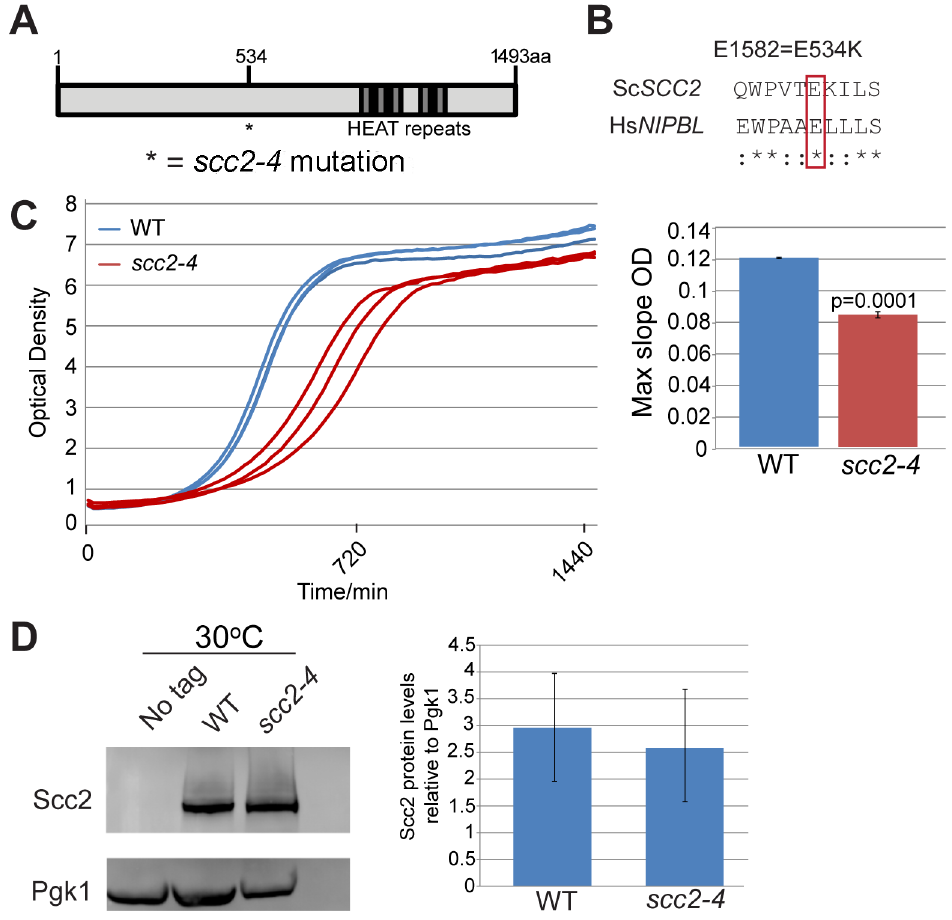
Fig 1. scc2-4 is a partial loss of function mutation. (A) Scc2 has conserved HEAT repeats in the C terminal domain. (B) The amino acid mutated in scc2-4 is conserved from yeast to human (E534). (C) A growth curve of the WT and scc2-4 mutant strains in YPD at 30°C is shown (left). Growth curves were measured using a TECAN machine. The scc2-4 mutant has a slower maximum growth rate at 30°C compared to the WT, p = 0.0001 (right). (D) The levels of Scc2-Myc were measured by Western blotting (left) and quantified (right, in triplicate with error bars). Pgk1 serves as a loading control. The E534K mutation does not significantly reduce the amount of Scc2 protein at permissive temperature